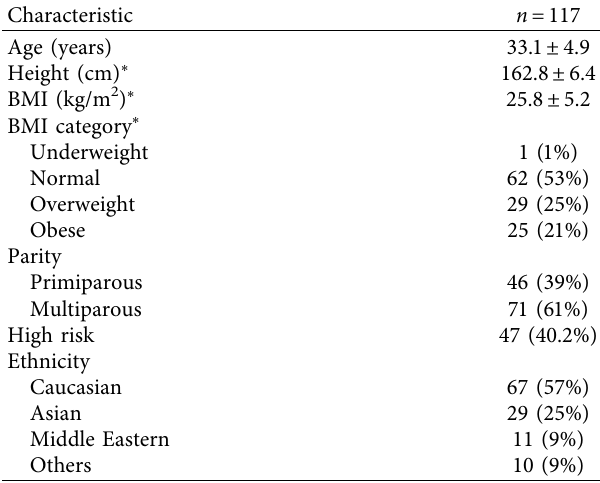
Table 1: Subject demographic